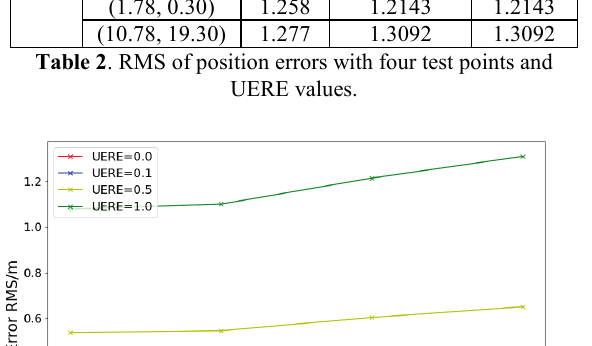
Figure 2 . DOP value distribution for ‘solution 1’.